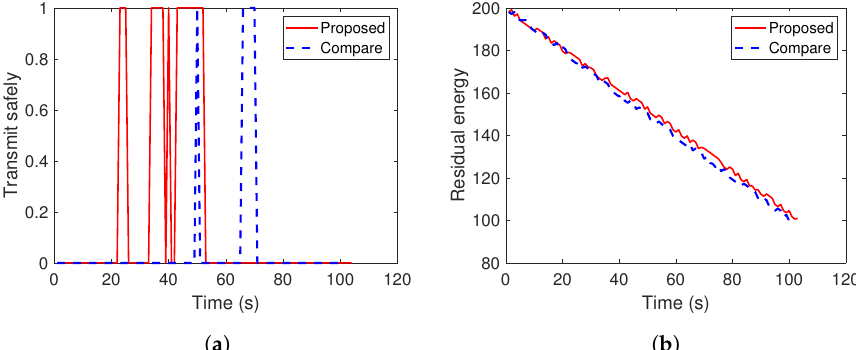
Figure 9. Simulation results of when the UAV can securely transmit data ( a ) and the residual energy ( b ) in case